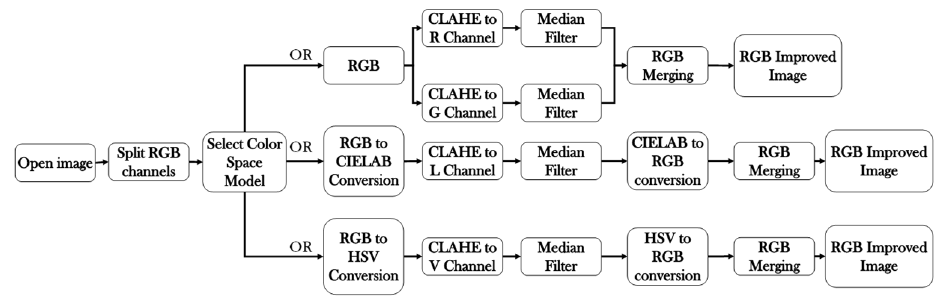
Figure 1. Block diagram of the method.